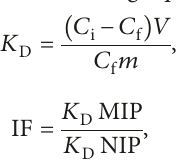
Figure 1: Relationship between 1/(methyl methacrylate) to 1/ Δ